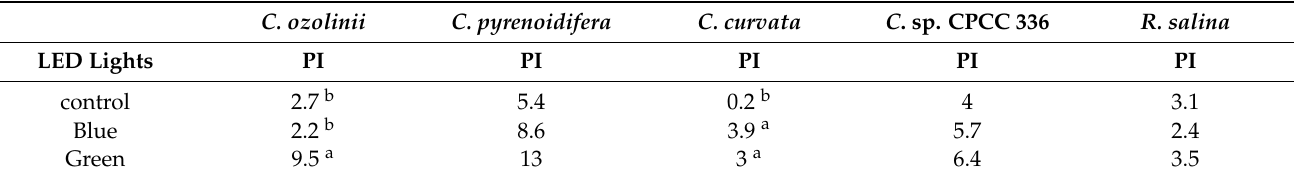
Table 1. Purity index (PI) of phycoerythrin extracted from studied cryptophyte algae cultured under three different LED lights.